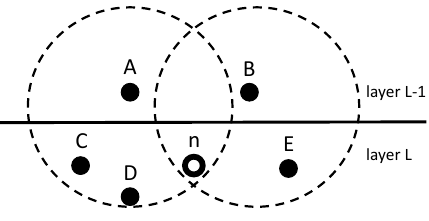
Figure 4. description of the competitor